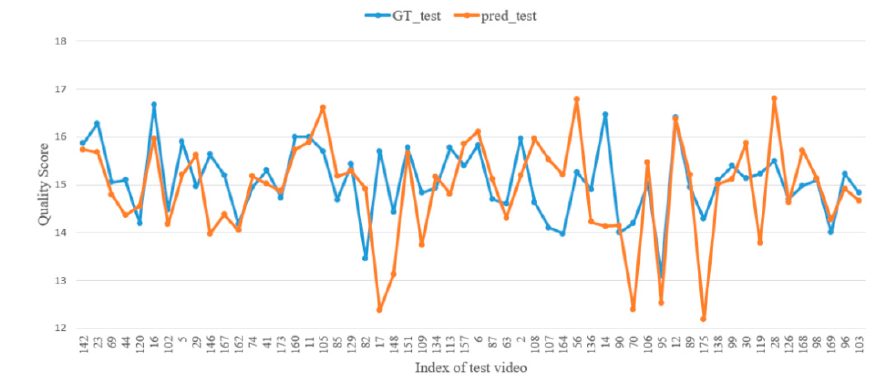
Figure 9. The predicted scores of test videos for the UNLV vault dataset.